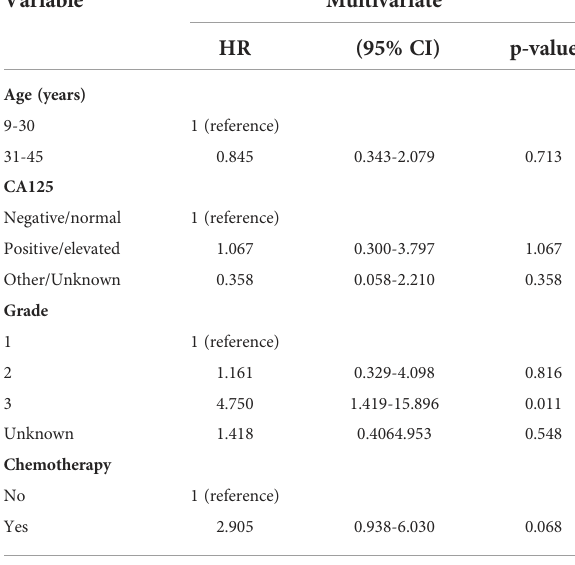
TABLE 4 Multivariate analysis of cancer-speci fi c survival among stage I MOC patients with FSS.